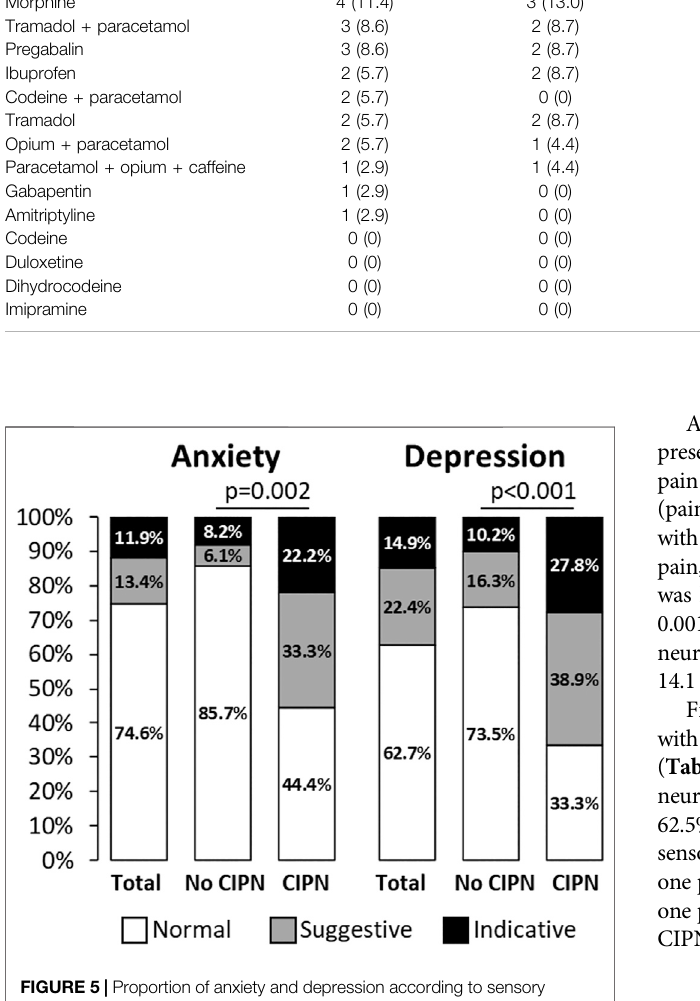
FIGURE 5 | Proportion of anxiety and depression according to sensory CIPN. The results are expressed as percentages. Normal scores of HADS were ≤ 7, suggestive 8 – 10 and indicative ≥ 11 for anxiety or depression. Statistical analysis was performed using Fisher ’ s exact test.